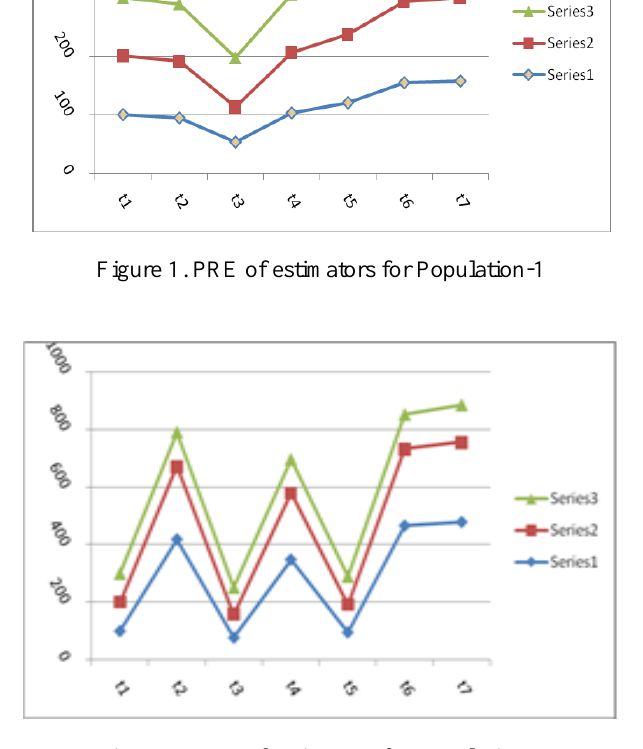
Figure 2. PRE of estimators for